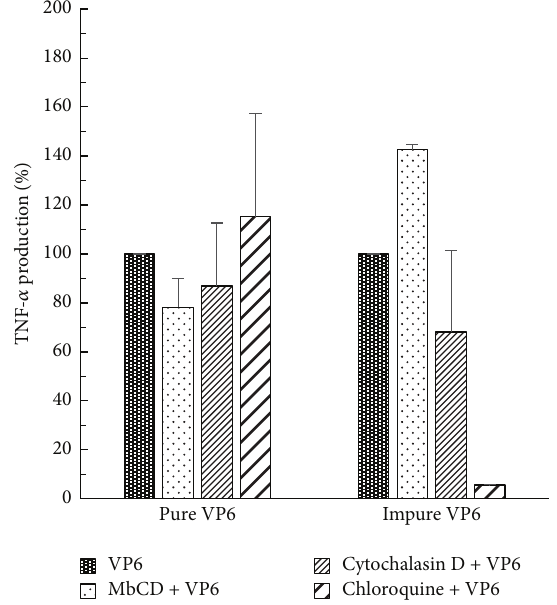
Figure 5: Effect of chemical inhibitors on VP6-induced TNF- 𝛼 secretion by RAW 264.7 cells. The change in TNF- 𝛼 production (%) by pharmacological inhibitors M 𝛽 CD, cytochalasin D, or chloroquine of cells stimulated with 50 𝜇 g/mL pure or impure VP6 nanotubes for 17h in the presence or absence of an inhibitor. VP6-induced TNF- 𝛼 production (pg/mL) without an inhibitor was considered 100%. Shown are the mean values of two independent analyses with standard